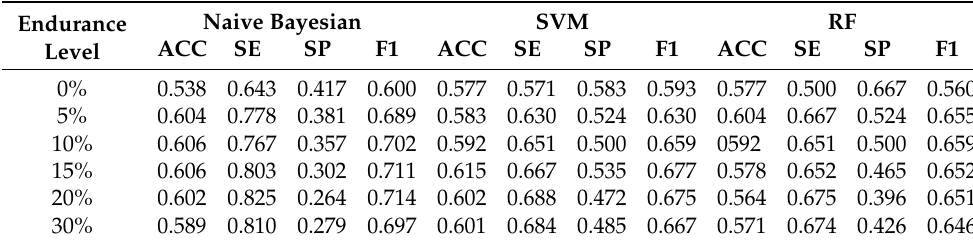
Table 4. Evaluation results of the naive Bayesian, SVM, and RF models by endurance levels. Naive Bayesian SVM RF Endurance Level